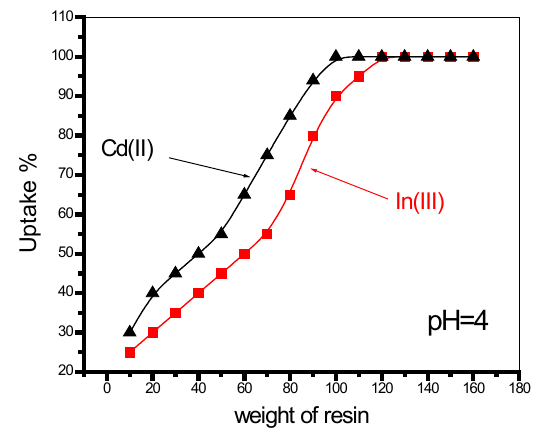
Figure 2. Effect of resin weight of dowex 50w-x8 on In(III) and